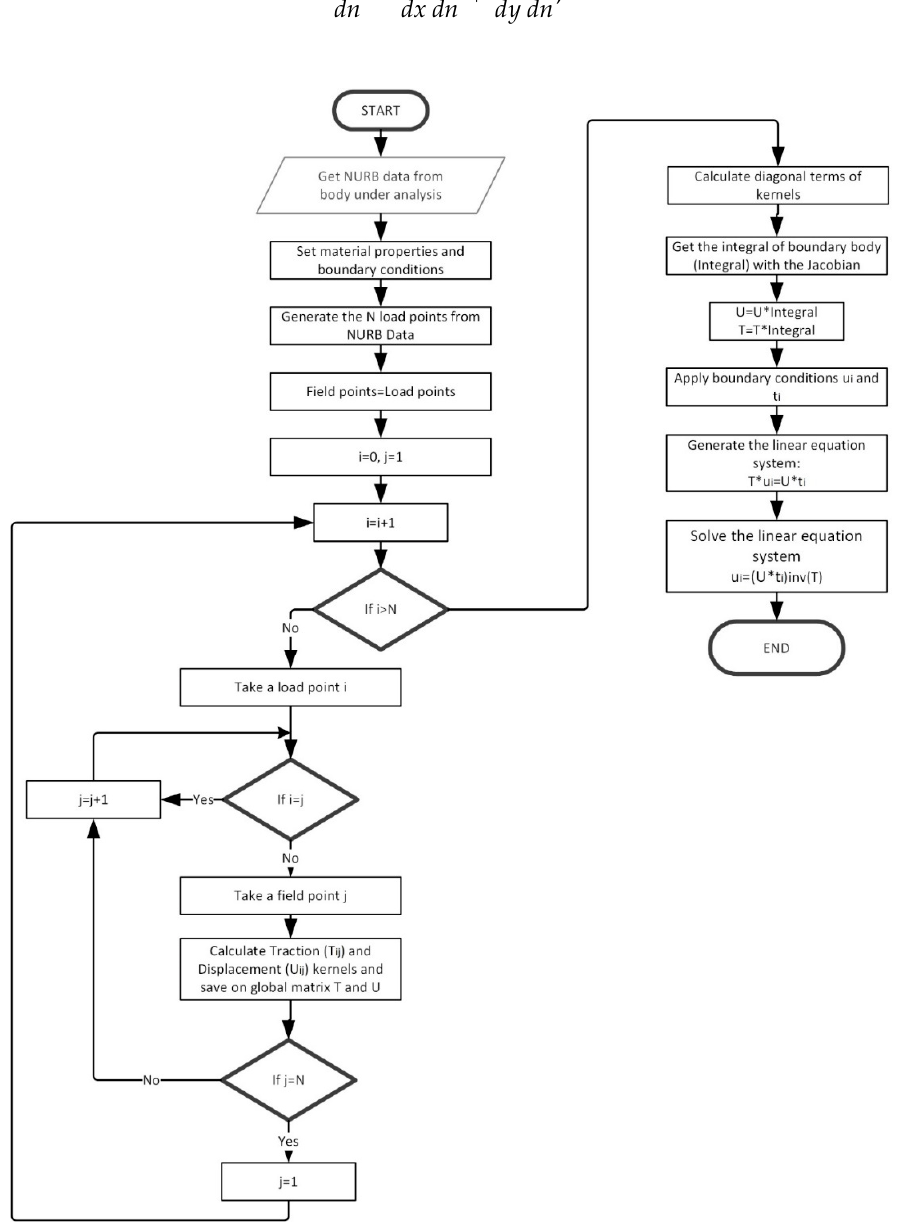
Figure 3. General flowchart of the proposed IGA-BEM.